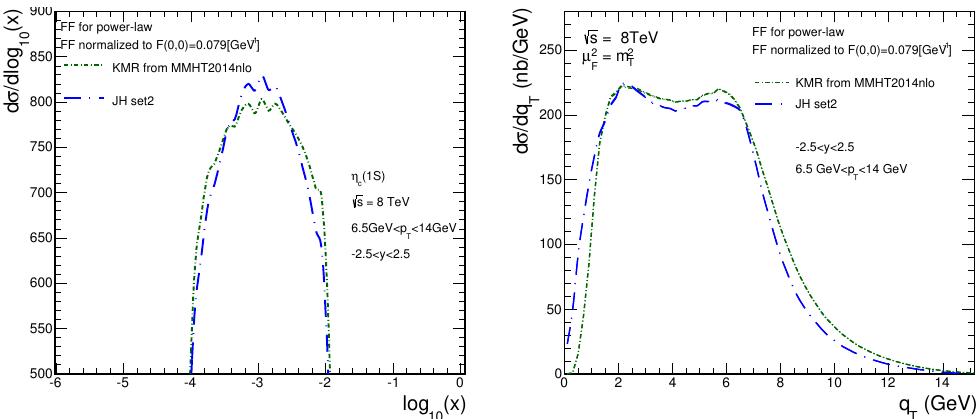
Figure 14 . Distribution in log panel) for ATLAS or CMS